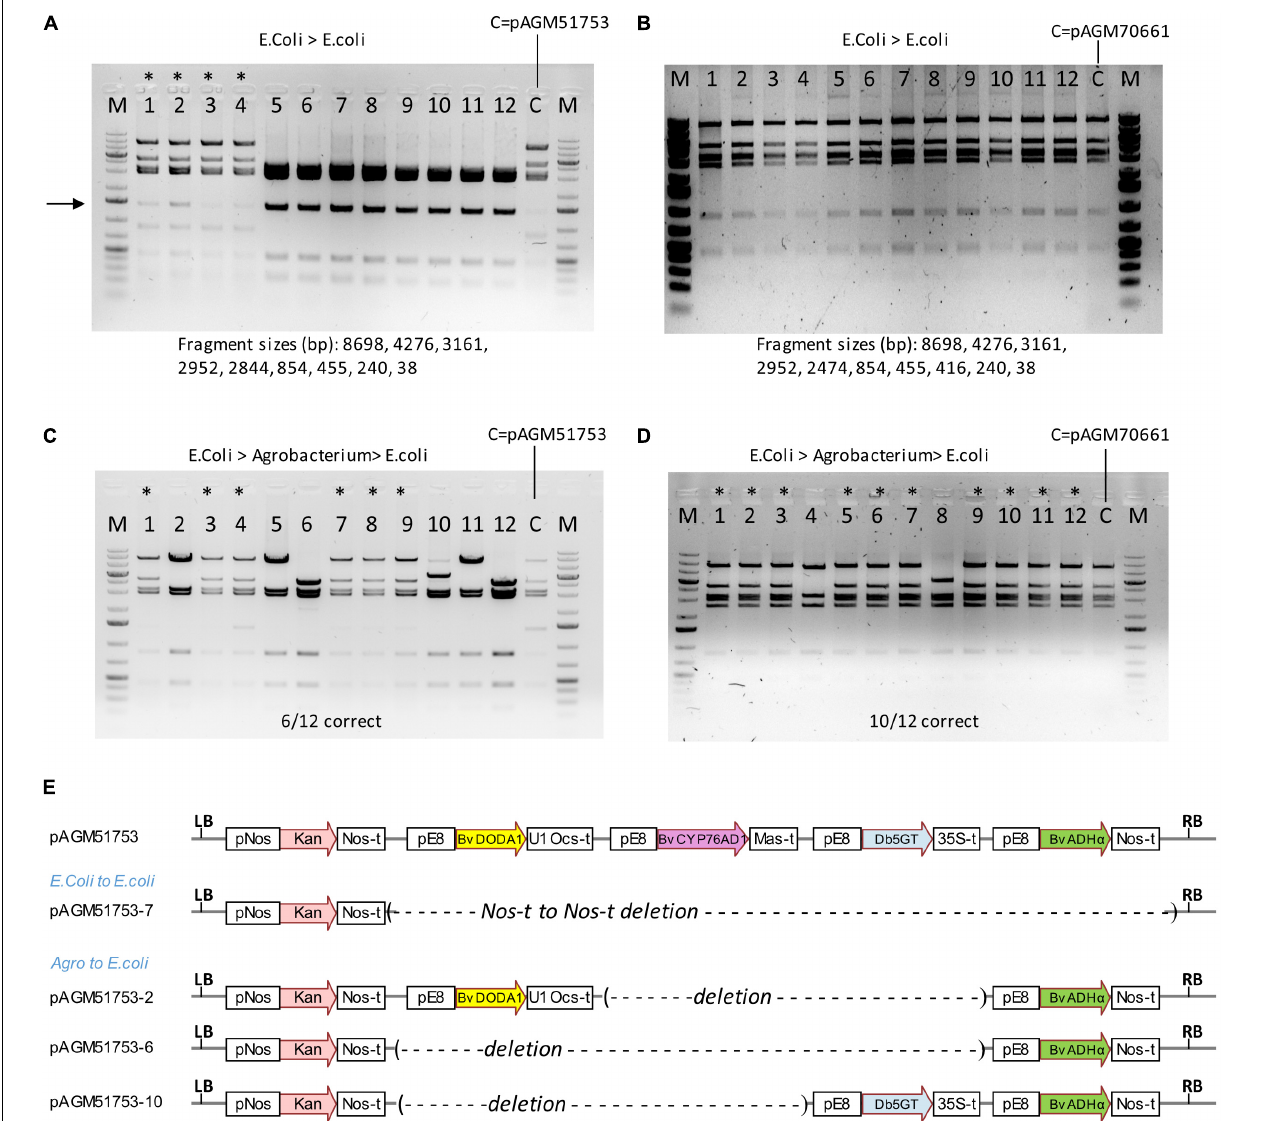
FIGURE 9 | Stability of constructs in high and low copy plasmid backbones. (A) Digests with NheI and SpeI of DNA of 12 minipreps made from colonies obtained after retransformation of the initial plasmid (pAGM51753) in E. coli . The original plasmid prep was digested and shown as a control (c). The first 4 minipreps were from small colonies, while the 8 others were from larger colonies. A DNA fragment of variable intensity (shown by an arrow) is visible in digests from minipreps 1–4, and from the miniprep from the initial plasmid. This fragment is the result of a recombination event in E. coli . (B) Same as in (A) with the low copy plasmid pAGM70661. In this case, all colonies had the correct size. (C) pAGM51753 plasmid was transformed in Agrobacterium strain GV3101. Plasmid DNA extracted from transformed agrobacterium cells was retransformed in E. coli . The restriction digest of 12 randomly picked colonies shows 6 colonies with the correct pattern (labeled with a star), and 6 colonies with recombined DNA. (D) Same as in (C) with construct pAGM70661. Digests with NheI and SpeI of plasmid DNA shows that 10 out of 12 colonies have plasmids identical to the starting non-recombined plasmid (labeled with a star). (E) Structure of construct pAGM51753 and of recombined plasmids pAGM51753-7 from (A) and pICH51753-2, 6, and 10 from (C)